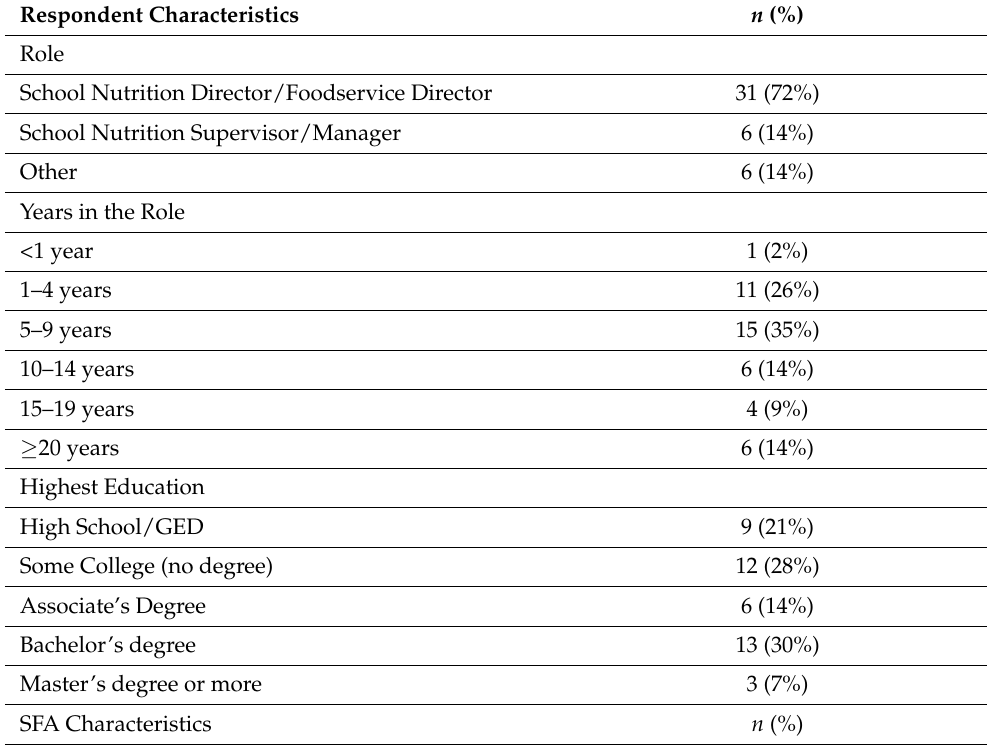
Table 1. Demographic Characteristics of the participating School Food Authorities (SFAs) in Maine ( n =